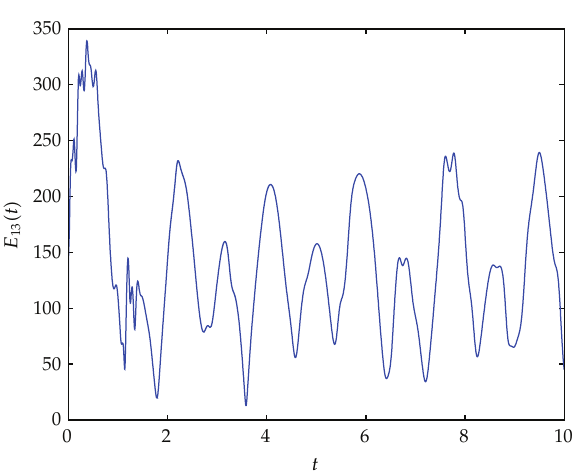
Figure 3: Time evolution of the synchronization errors E 13 (cid:6) t (cid:7) .